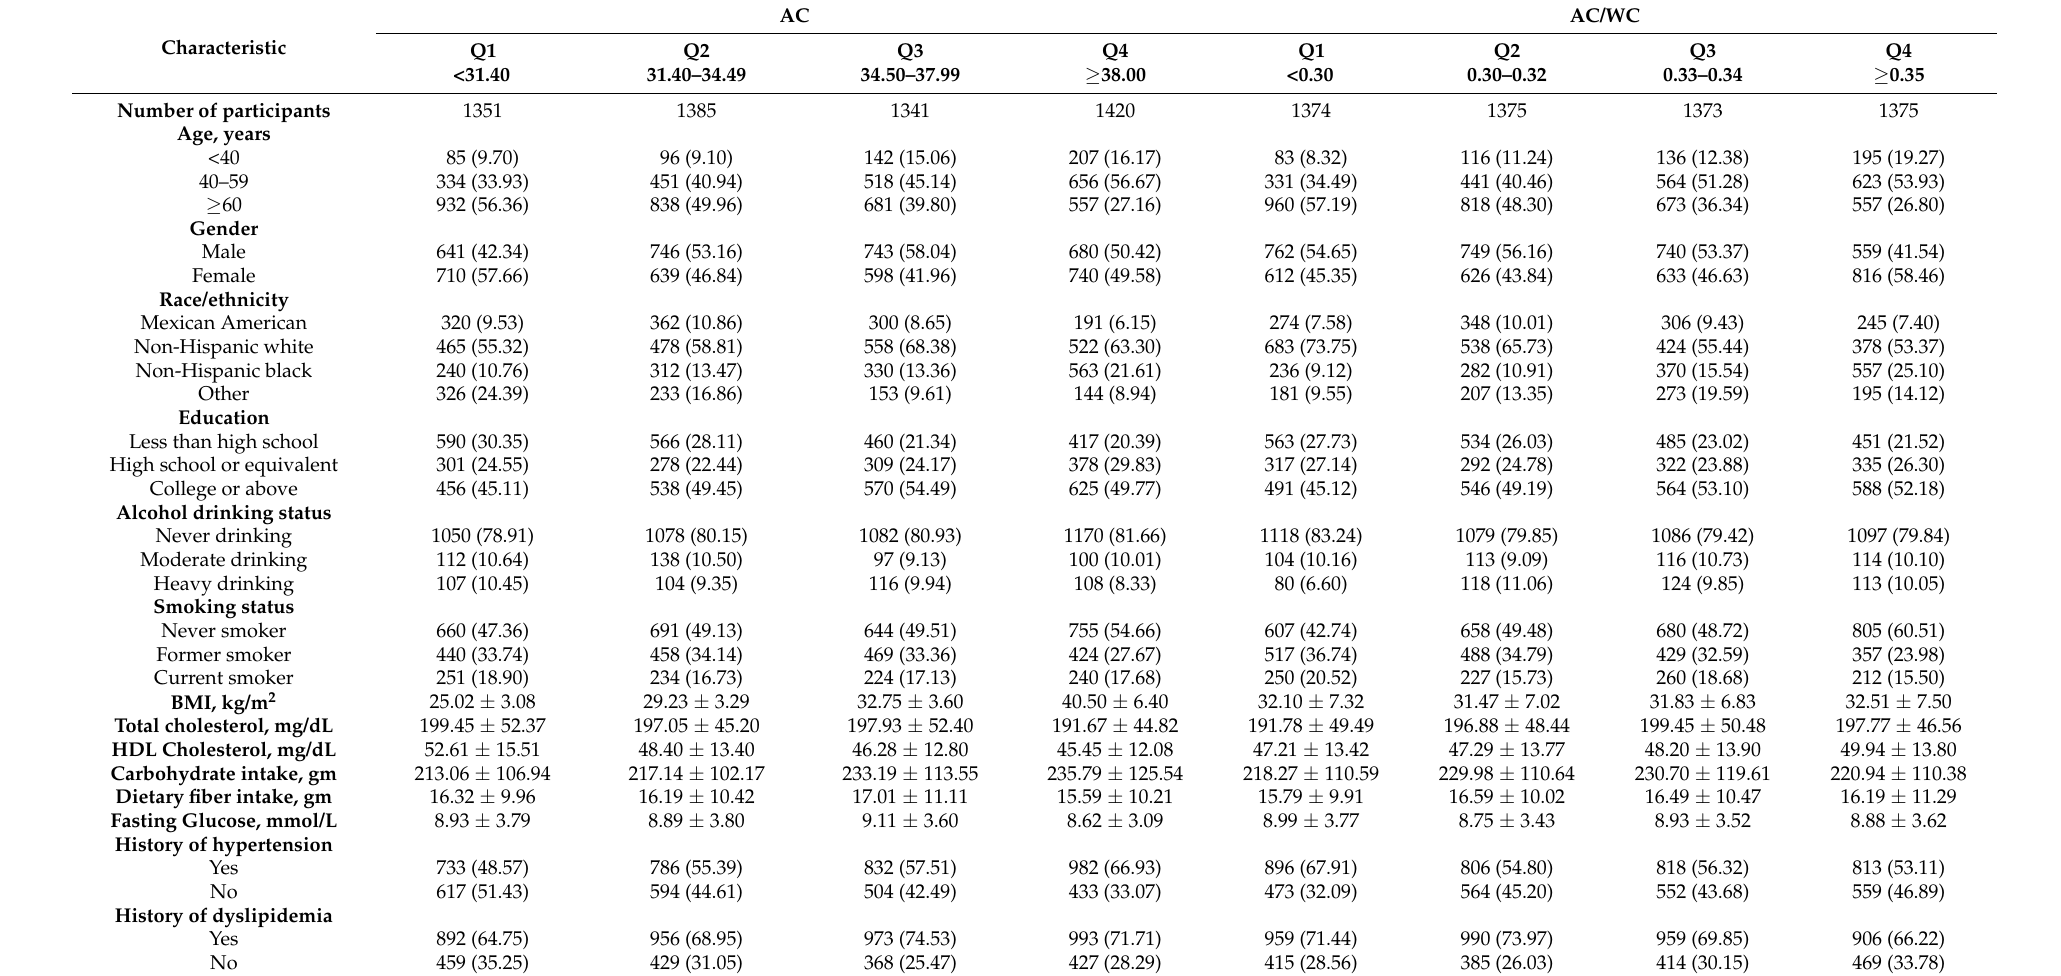
Table 1. Baseline characteristics of the study population, according to AC and